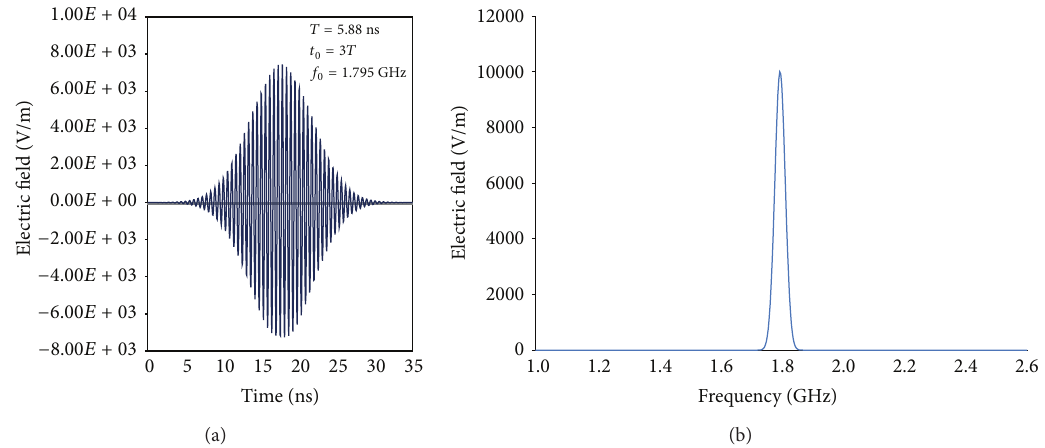
Figure 3: The sinusoidally modulated Gaussian pulse wave 𝐸 = 𝐸 0 exp (−[(𝑡 − 𝑡 0 )/𝑇] 2 ) sin 2𝜋𝑓 0 (𝑡 − 𝑡 0 ) , where 𝐸 0 = 10, 541 V/m, 𝑡 0 = 3𝑇 , = 1795 MHz. (a) Time domain. (b) Frequency domain. 𝑇 = 5.88 × 10 −9 s, and 𝑓 0